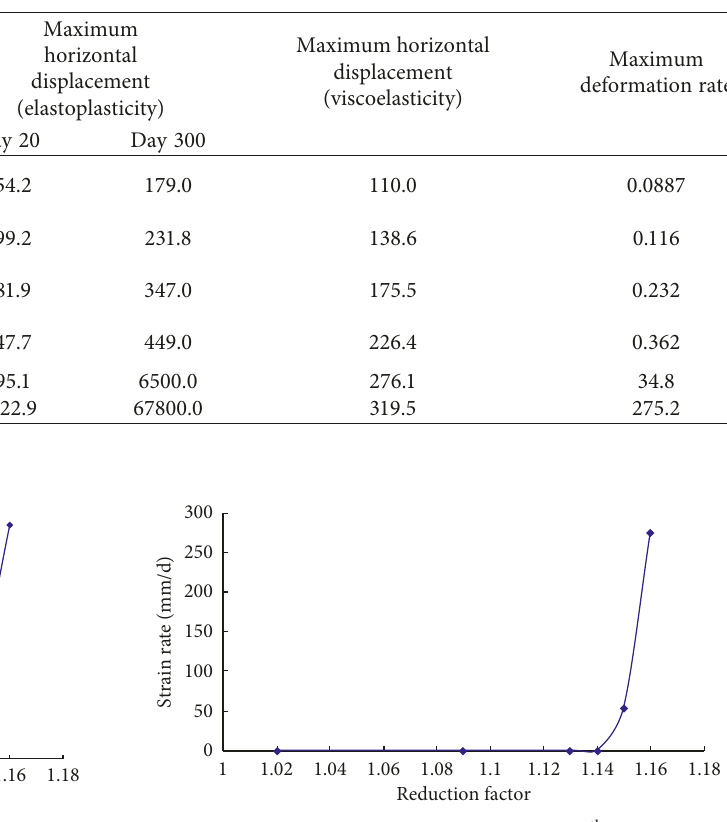
Figure 13: Horizontal displacements of the 300 th day with a key point of 5 under different reduction factors.